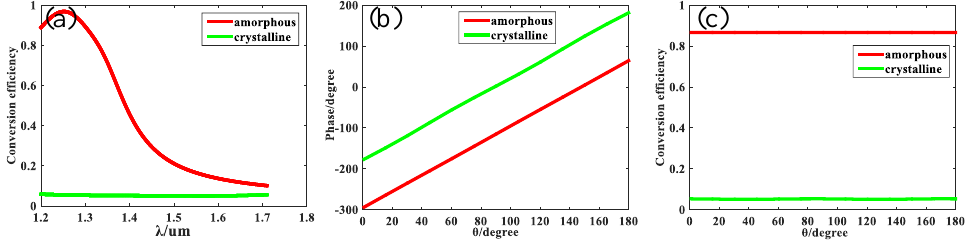
Figure 2. ( a ) The conversion efficiency from LCP to RCP versus wavelength for unit cell U 1 when GST stays in amorphous state (red line) and crystalline state (greed line). ( b ) The phase modulation of unit cell U 1 versus rotating angle θ for both states of GST at the designed wavelength of 1.31 μm. ( c ) The conversion efficiency of unit cell U 1 from LCP to RCP versus rotating angle θ for both states at the designed wavelength of 1.31 μm.